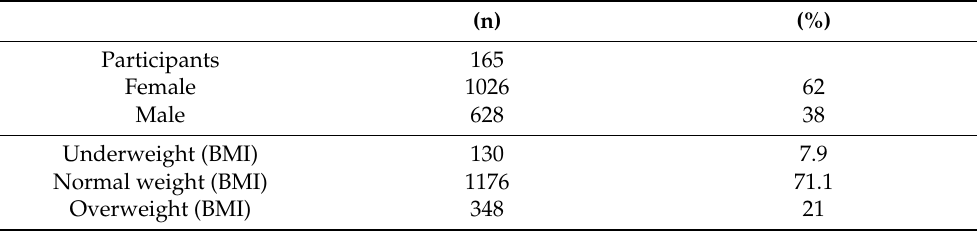
Table 1. Characteristics of